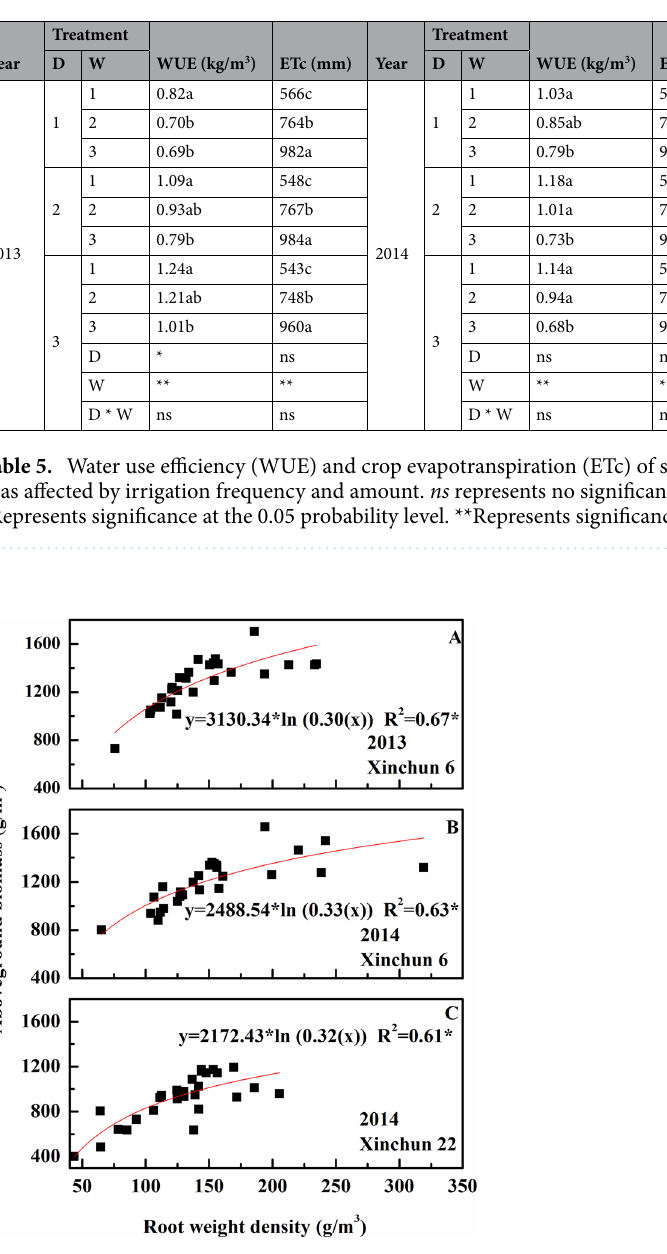
Figure 9. Relationship between root weight density and aboveground biomass in 2013 and 2014. ( A ) Relationship between root weight density and aboveground biomass of Xinchun 6 in 2013. ( B ) Relationship between root weight density and aboveground biomass of Xinchun 6 in 2014. ( C ) Relationship between root weight density and aboveground biomass of Xinchun 22 in